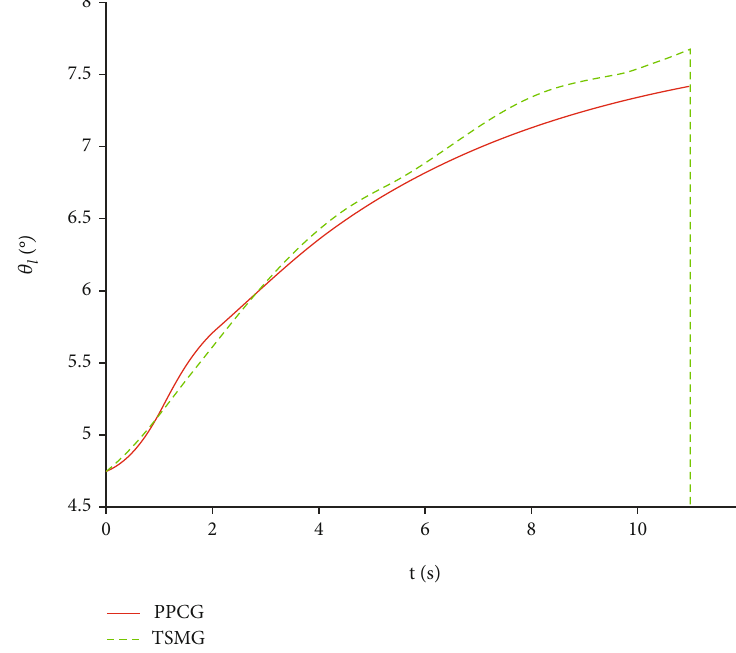
Figure 17: Comparison of LOS angular